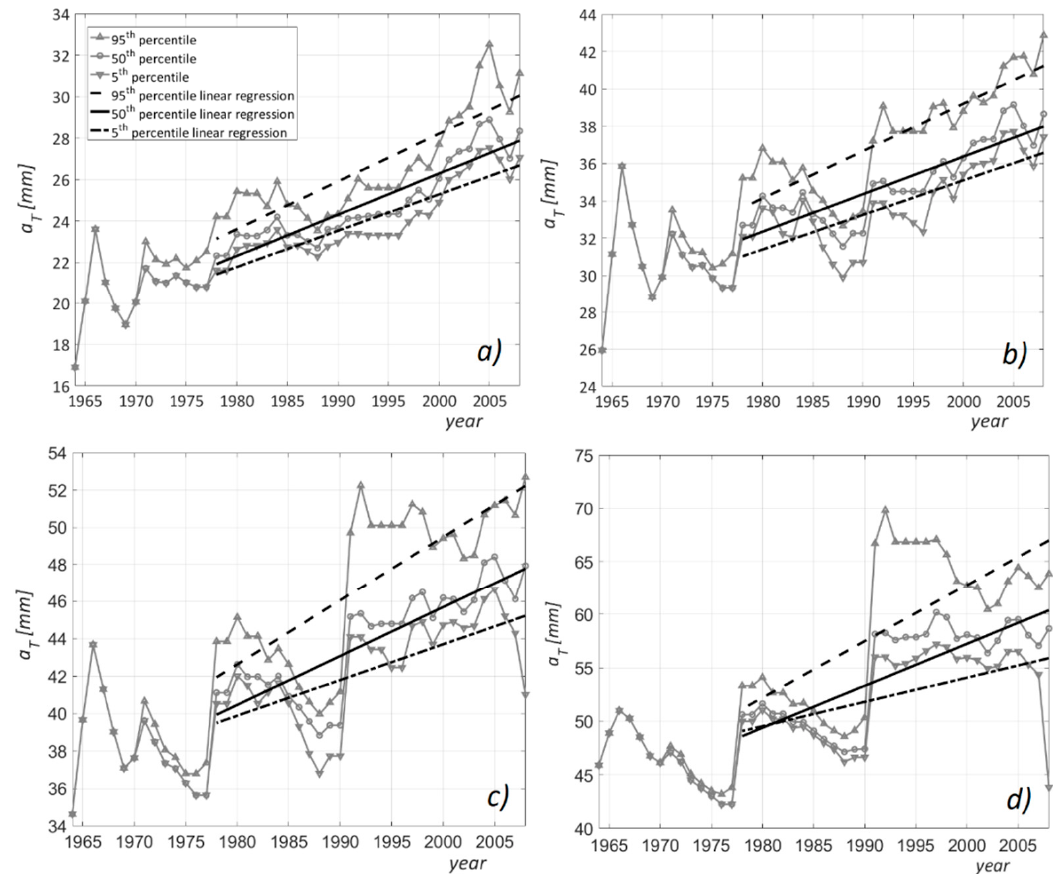
Figure 3. The 95th, 50th, and 5th percentiles of the aT parameter and linear regressions for different return periods T : ( a ) 2 years; ( b ) 5 years; ( c ) 10 years; and ( d ) 20 years.